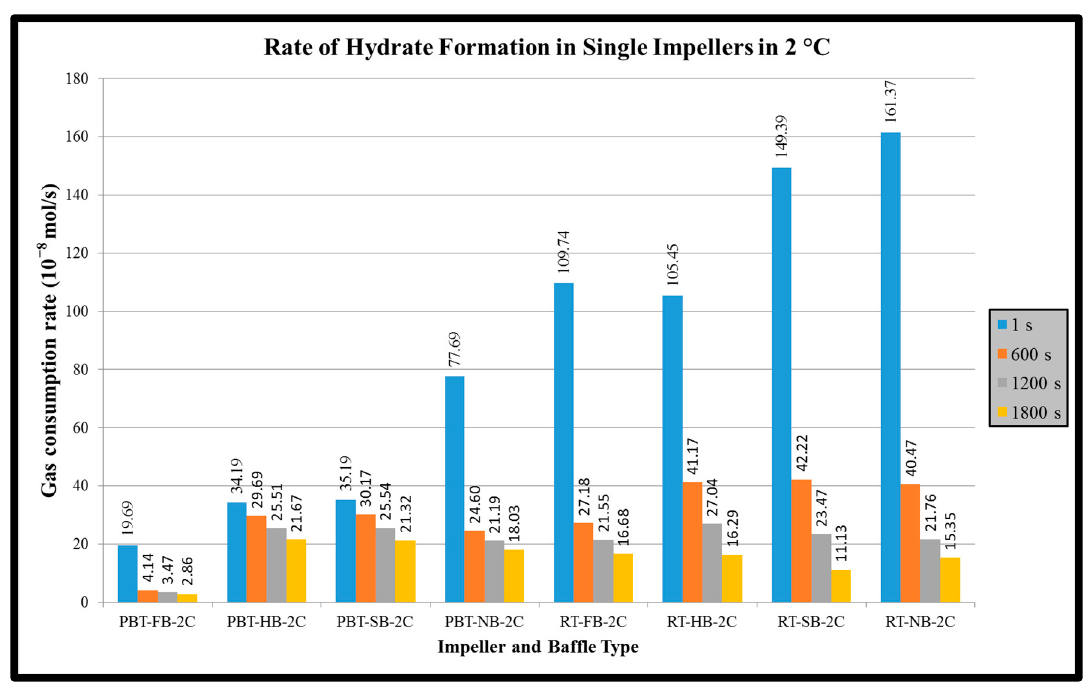
Figure 9. Rate of hydrate formation of mixture gas with dual impeller (experimental temperature 2 °C).